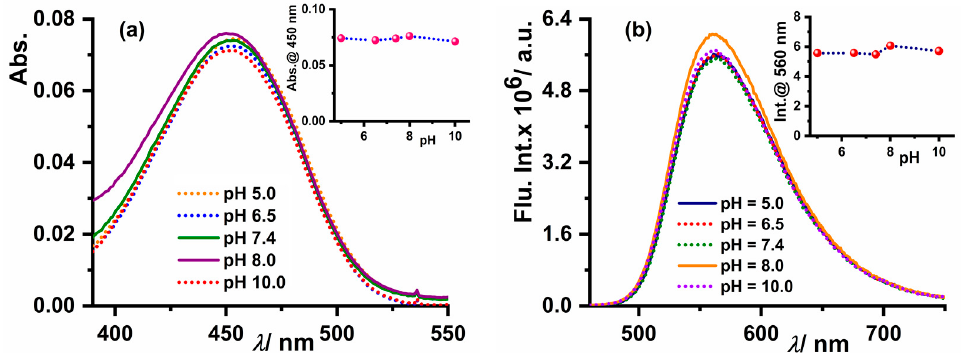
different pH; inset graph representing the change in absorbance at 450 nm and intensity at 560 nm while changing the pH of the solutions. while changing the pH of the